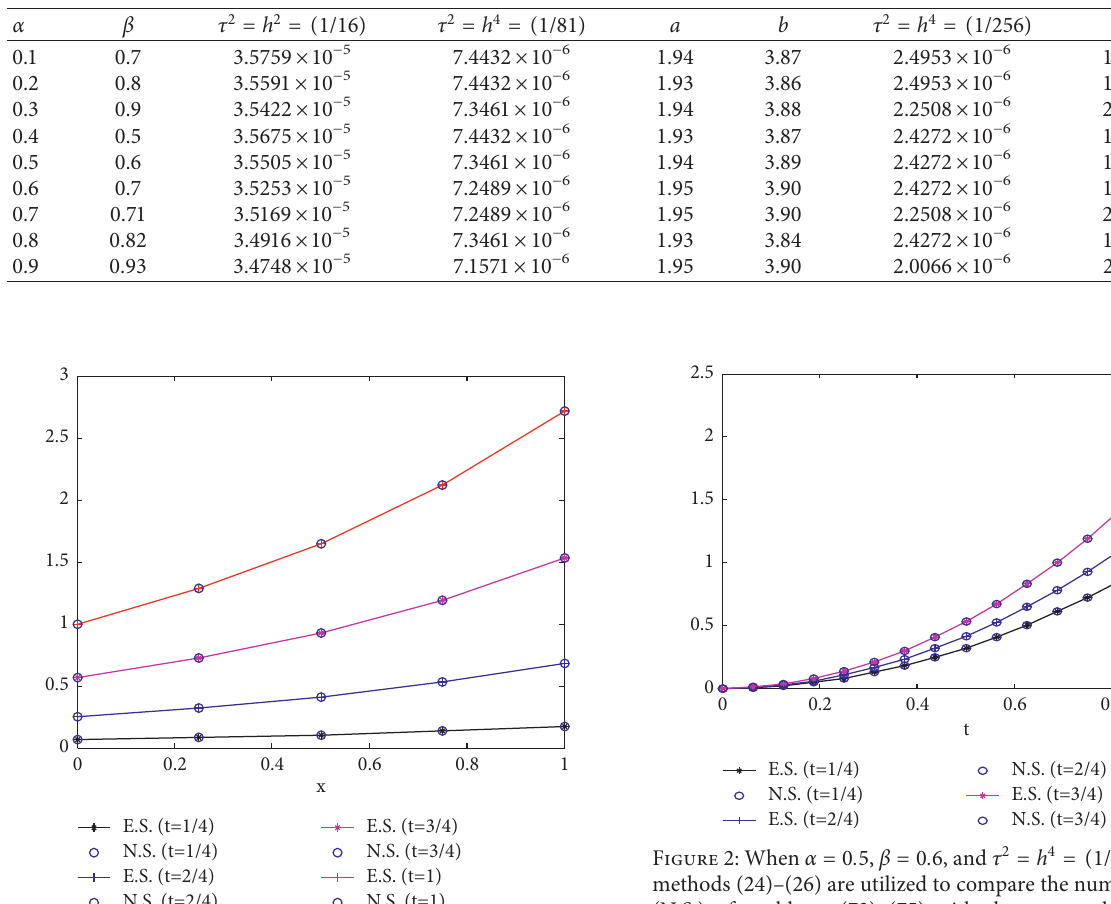
Table 1: Maximum error E ∞ , time accuracy, and spatial accuracy b of numerical equations (24)–(26) for solving problems (73)–(75).